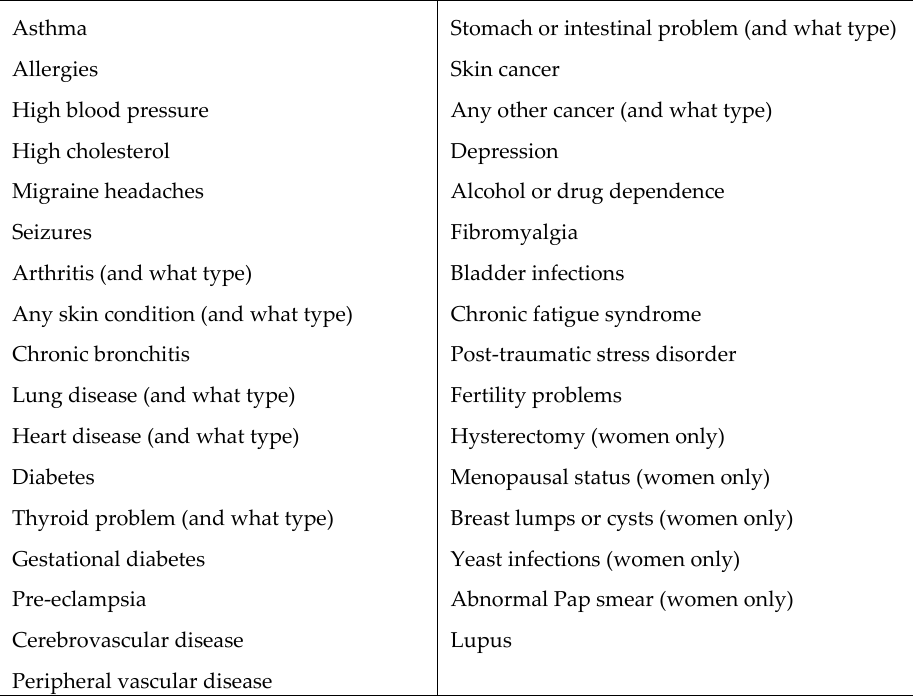
Table 1. Medical conditions that will be examined in the Gulf War Women’s Cohort study.